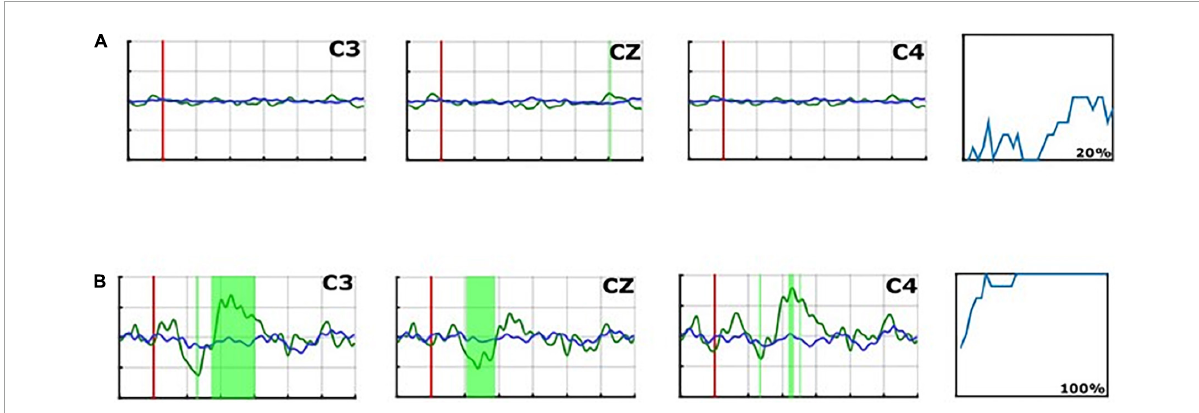
FIGURE3 Average P300 ERP waveforms of the “C3,” “Cz,” and “C4” electrodes in run 1 for Patient 16 (A) , and for Patient 8 (B) . The red line presents the averaged non-target trials. The averaged target trials are plotted in blue. The magenta vertical line shows the trigger time. Green areas mark areas in which the target vs. non-target lines differ